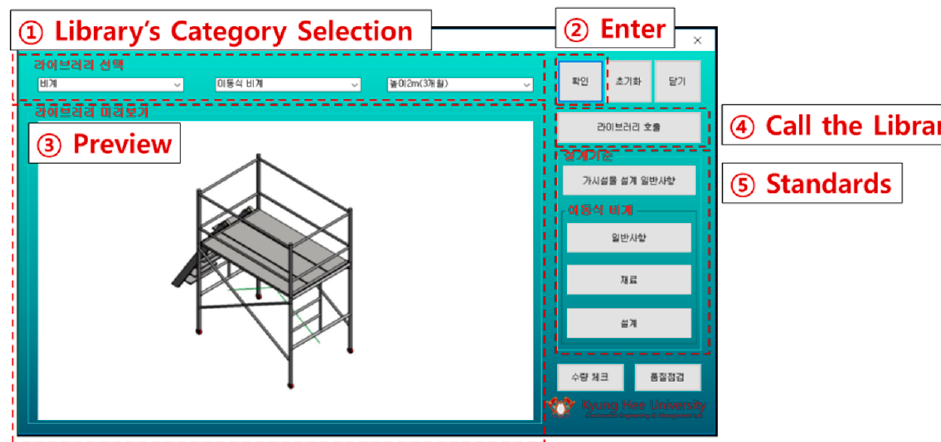
Figure 4. BIM modeling module.